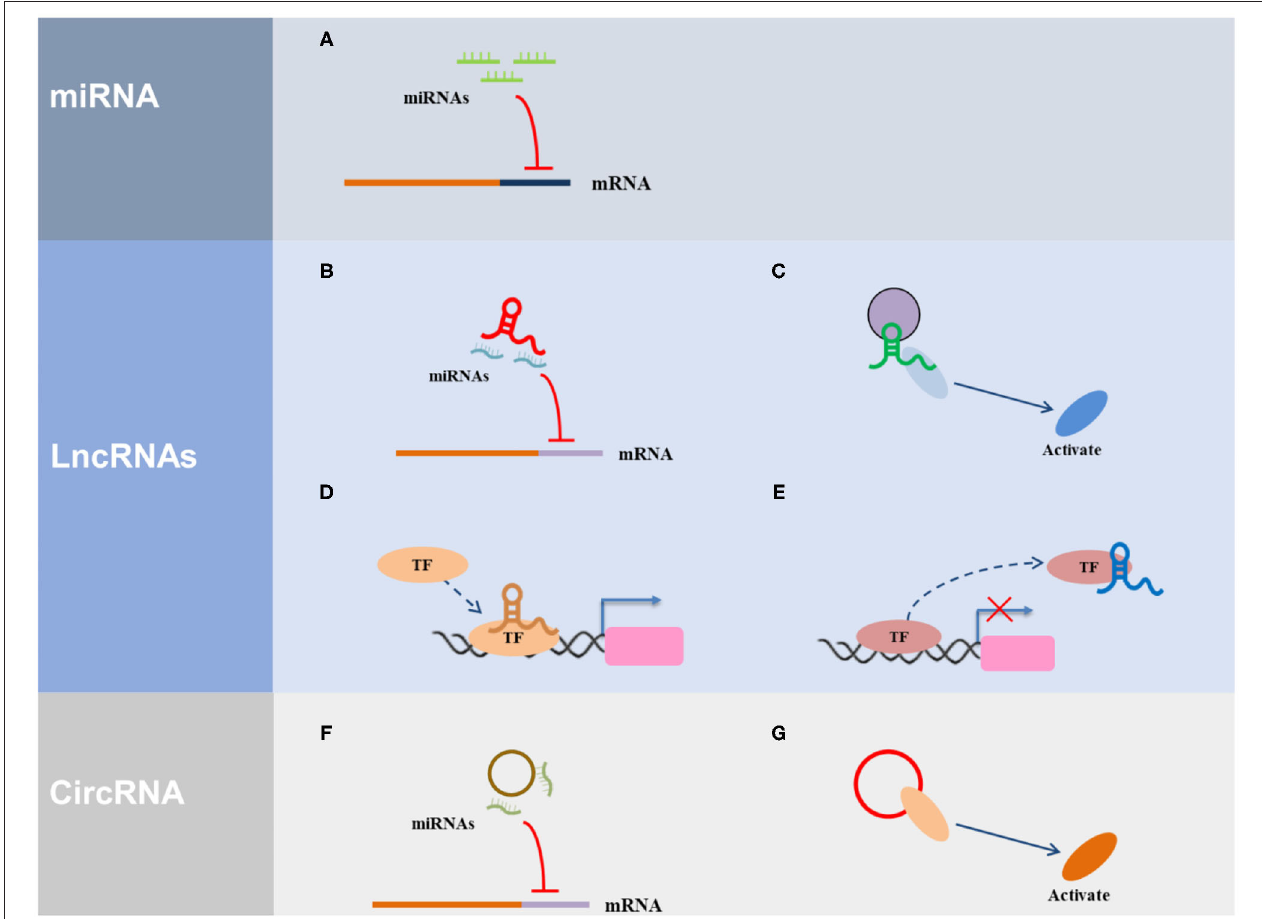
FIGURE 1 | The regulatory mechanism of ncRNAs. (A) miRNA can direct bind with the 3 ′ UTR of the target gene. (B) LncRNA serves as ceRNA to interact with miRNAs. (C) LncRNA acts as a scaffold via recruiting and interacting with proteins and regulate the activity of proteins. (D) LncRNA acts as a guide to promote the gene expression via recruiting transcription factors (TF) to the region of the gene promoter. (E) LncRNA acts as a decoy via interacting with TF to inhibit transcriptional regulation. (F) CircRNA serves as ceRNA to interact with miRNAs. (G) CircRNA acts as a scaffold via recruiting and interacting with proteins and regulate the activity of